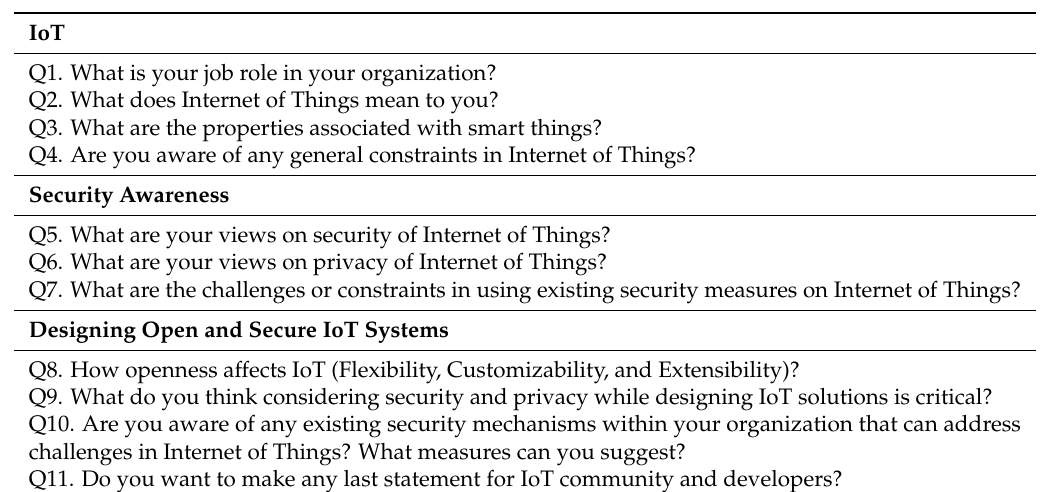
Table 2. Interview